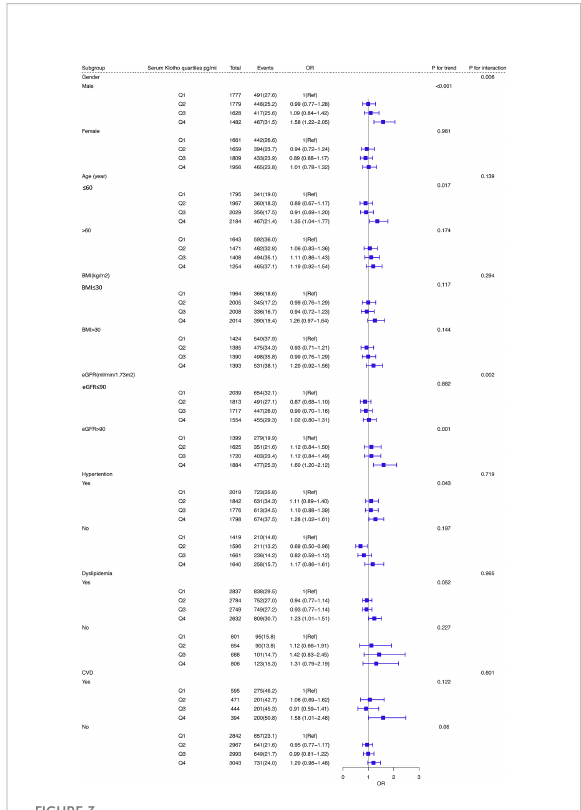
FIGURE 3 Subgroup analyses of the association between serum Klotho levels and DM in the database from NHANES 2007 – 2016. Adjusted for age, sex, educational level, race, BMI, waist circumference, smoking status, alcohol intake, physical activity, CVD, hypertension, dyslipidemia, total cholesterol, LDL-C, HDL- C, triglyceride, and eGFR. Abbreviations: NHANES: the National Health and Nutrition Examination Survey; BMI, body mass index; CVD, cardiovascular disease; DM, diabetes mellitus; LDL-C, Low- Density Lipoprotein Cholesterol; HDL-C, High density leptin cholesterol; eGFR, estimated glomerular fi ltration